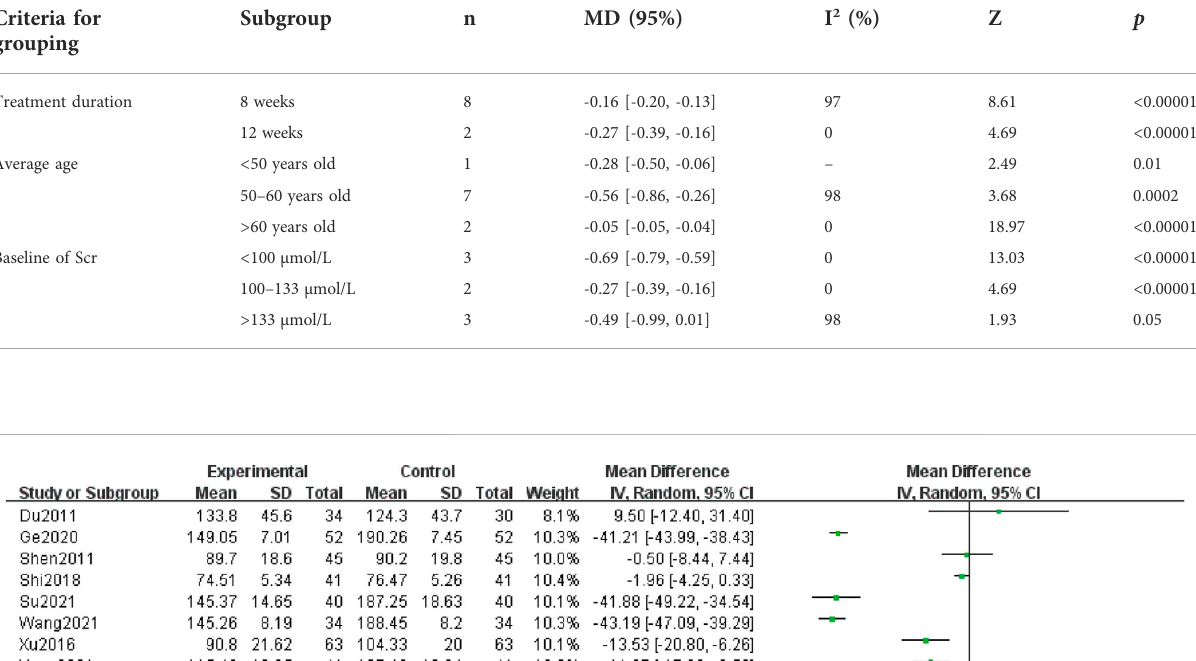
TABLE 2 Subgroup analyses of 24 h-UP based on treatment duration, average age, and baseline of Scr. Criteria for grouping